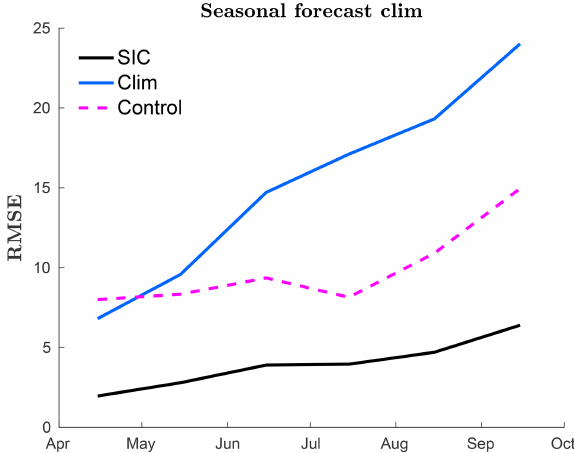
Figure 10. Seasonal forecast of summer sea-ice extent, both with climatological forcing and reanalysed forcing. Each forecast started at the beginning of April every year. The figure describes monthly averaged RMSE SIC averaged over all ensemble members. The blue line represents a forecast using a climatological forcing made from atmospheric data over 2000–2014 with assimilation, the black line using reanalysed atmospheric forcing and assimilation, and the dot- ted magenta line use reanalysed forcing